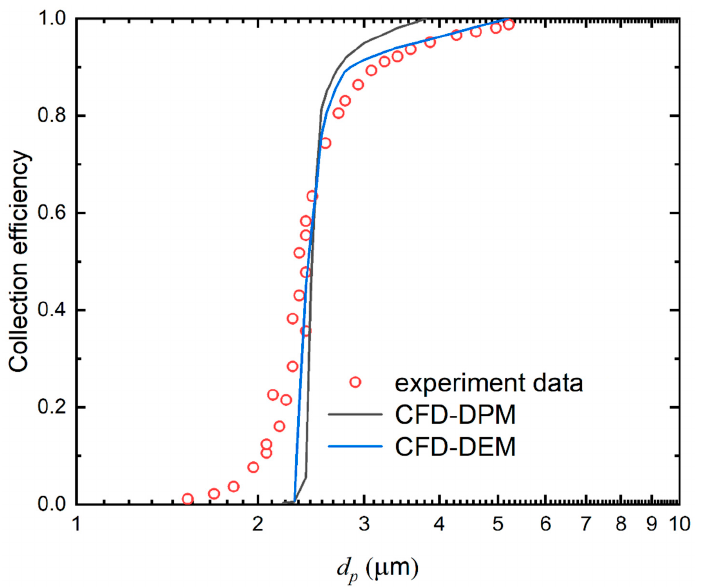
Table 3. Comparisons of slope of the efficiency curves obtained from CFD-DPM method, CFD-DEM method, and the experimental result [34] in Figure 2.